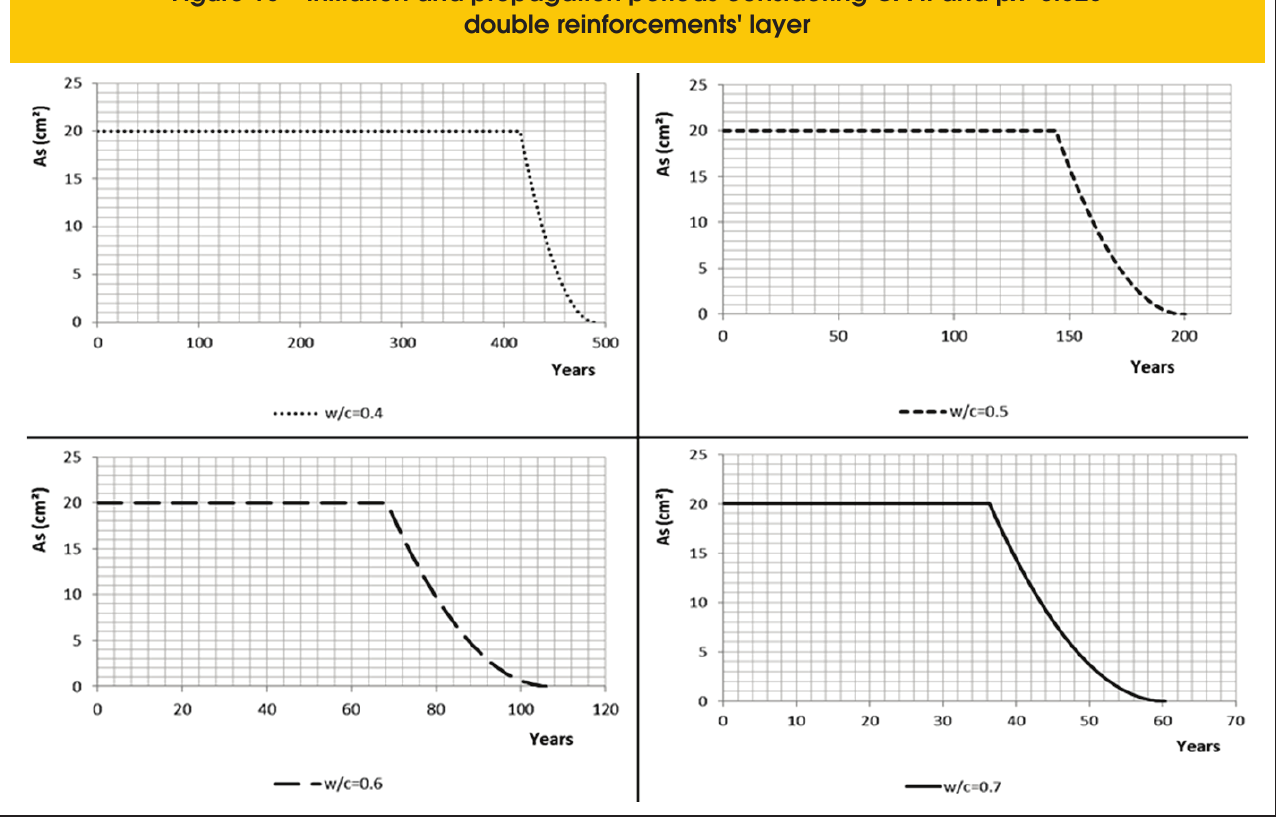
Figure 15 – Initiation and propagation periods considering CA II and β x=0.628 double reinforcements'